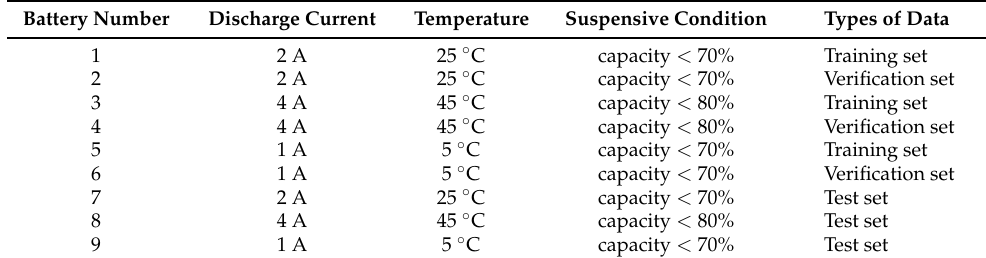
Table 3. Battery discharge test